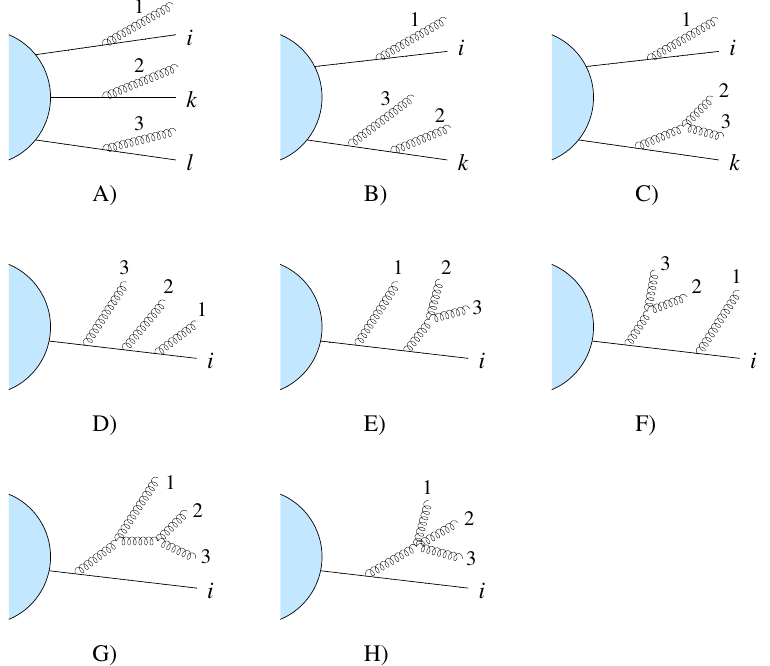
Figure 2 . Diagrams contributing to the three-gluon soft